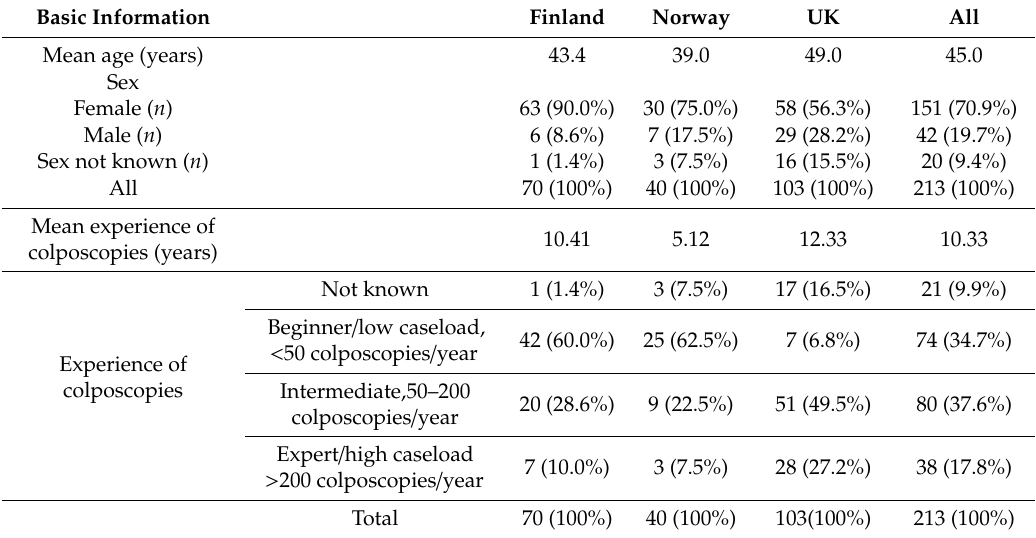
Table 1. Demographic information about the participants.